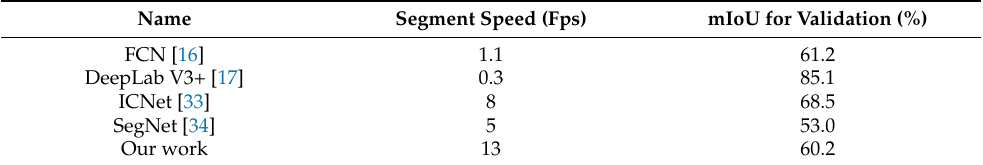
Table 4. Comparison of the segmentation execution speed.